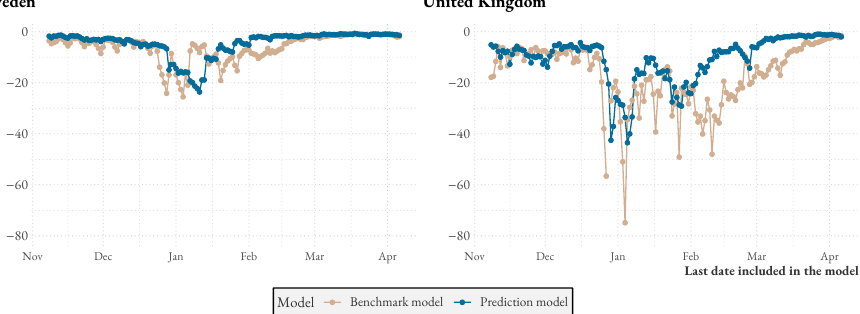
Figure A1. Mean CRPS as the pandemic progresses.